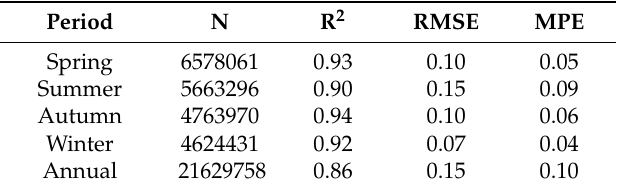
Table 1. Sample-based CV results of seasonal and annual XGBoost models. Period N R